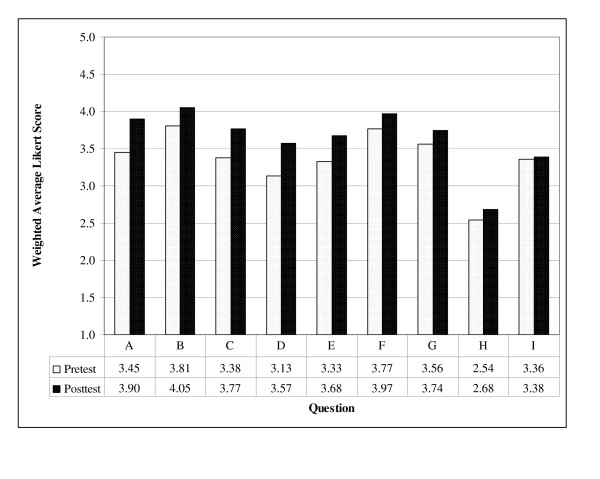
Weighted average Likert score pretest and posttest.